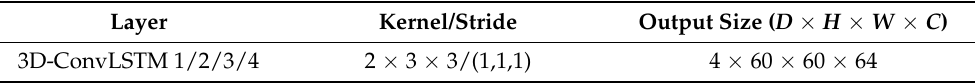
Table 3. Architecture of 3D-convolutional long short-term memory (ConvLSTM) layer. Layer Kernel/Stride